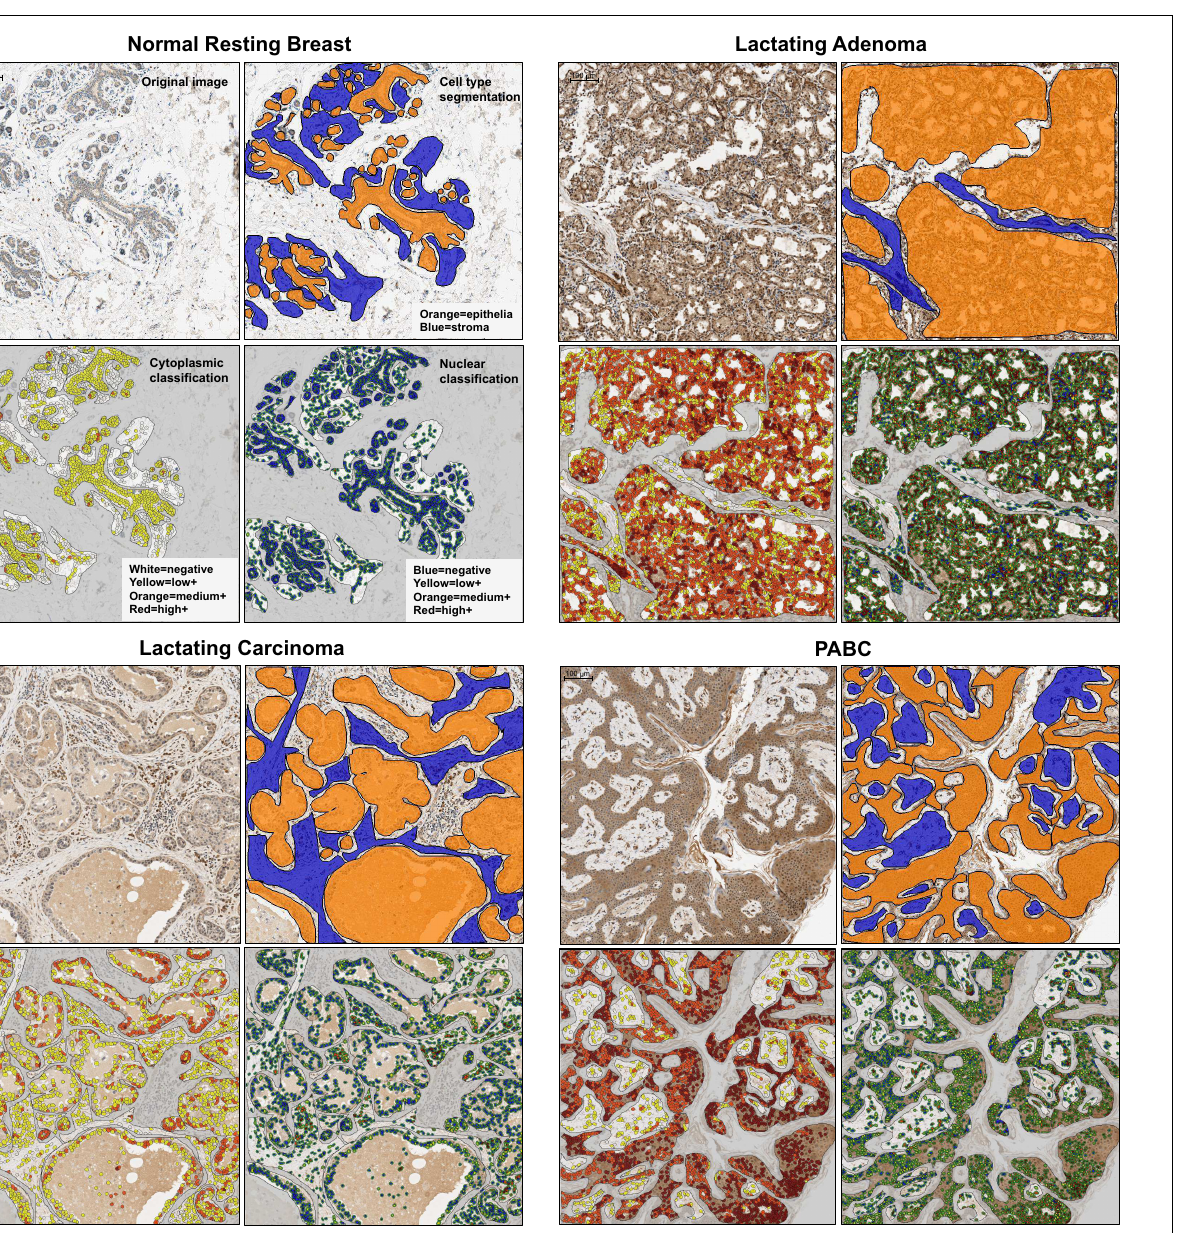
FIGURE 3 | Representative examples of the examined tissues showing cell type segmentation and cytoplasmic and nuclear classification for different staining intensities used for quantification of OCT4 expression in the epithelium and in the stroma. For each sample type, the top left panel is the raw image; the top right illustrates the epithelial/stromal segmentation with orange representing epithelial regions and blue the